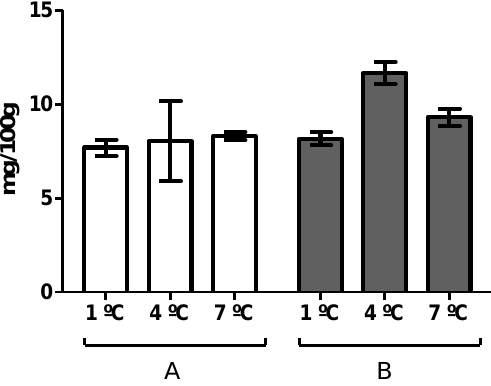
Figure 1. Trimethylamine (TMA) content at the time of spoilage of hake fillets stored in modified atmosphere (MAP) of the two batches studied (A and B) and at each of the storage temperatures investigated (1, 4, and 7 °C). Error bars represent the standard deviation.